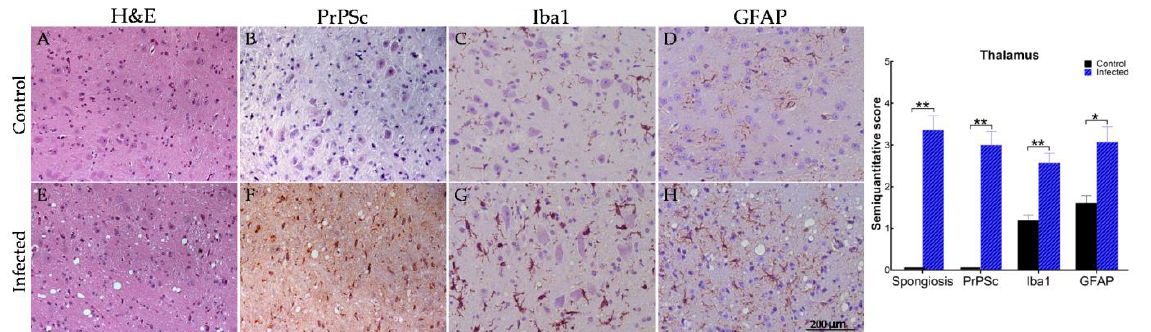
Figure 4. Thalamus sections from scrapie-infected (intracerebral inoculation) and age-matched tg338 control mice immunostained to assess spongiosis (hematoxylin–eosin), PrP Sc deposition (R486 antibody), astrocytes (glial fibrillary acidic protein; GFAP), and microglia (ionized calcium-binding adaptor molecule-1; Iba1). ( A , E ) Severe spongiform lesions located mainly in the neuropil of scrapie-infected versus control mice. ( B , F ) Several PrP Sc -positive neurons are evident in scrapie-infected mice, but absent from controls. ( C , G ) Activated microglia displaying more intense immunostaining and thick processes in scrapie-infected mice versus controls. ( D , H ) Increased astrogliosis with hypertrophic cell bodies and processes in scrapie-infected mice versus controls. Scores range from 0 (negative) to 5 (maximum intensity). Significant differences were determined using Student’s t-test or Mann–Whitney U test for normally and non-normally distributed data, respectively. * p < 0.05 , **p < 0.01. Scale bar = 200 µm.